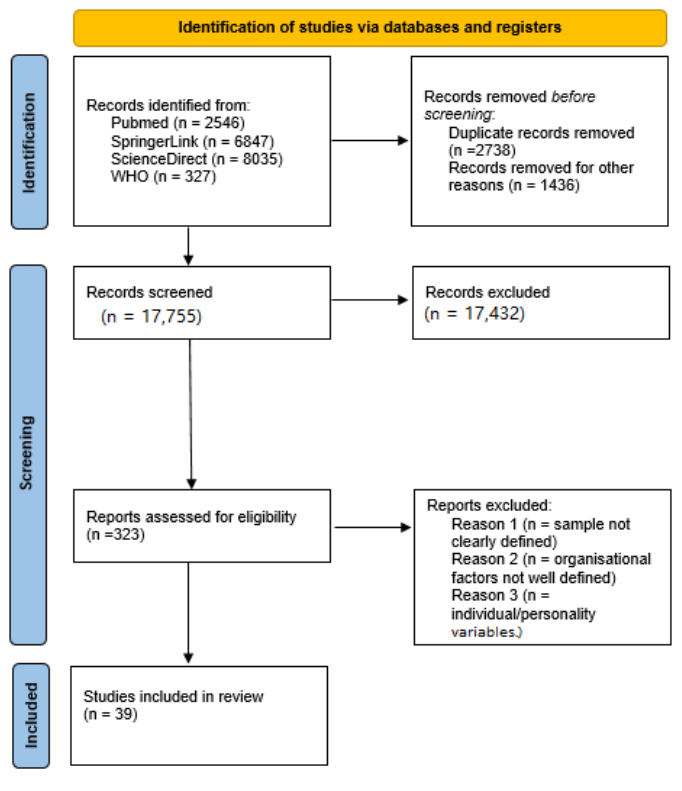
Figure 1. Flow Figure 1. Flow chart. Table 1. Summary of the selected studies for the mini review.